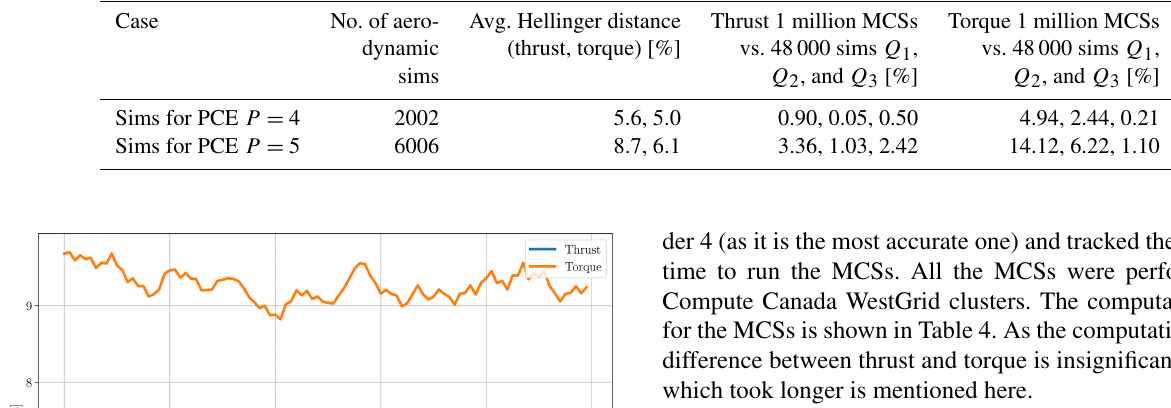
Table 2. The average Hellinger distance for polynomials P = 4 and P = 5 and the quantile value difference with respect to the reference case.